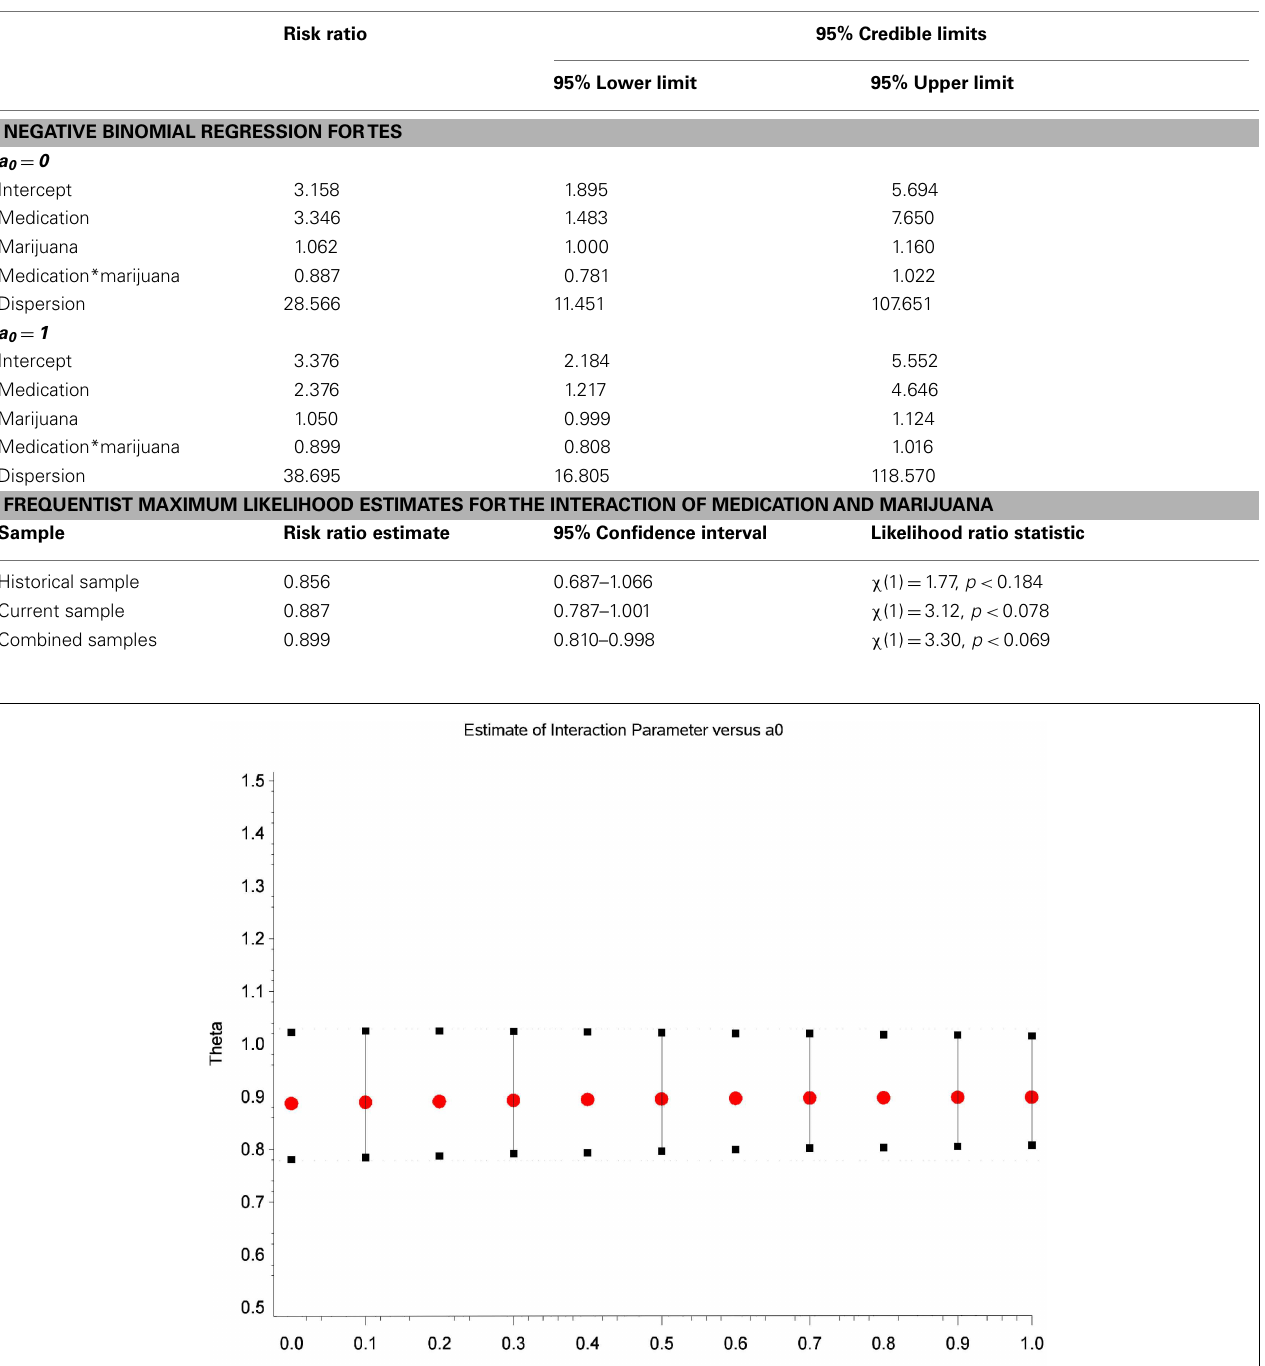
Table 2 | Exponentiated parameter estimates and 95% credible intervals for a 0 = 0 and a 0 = 1.